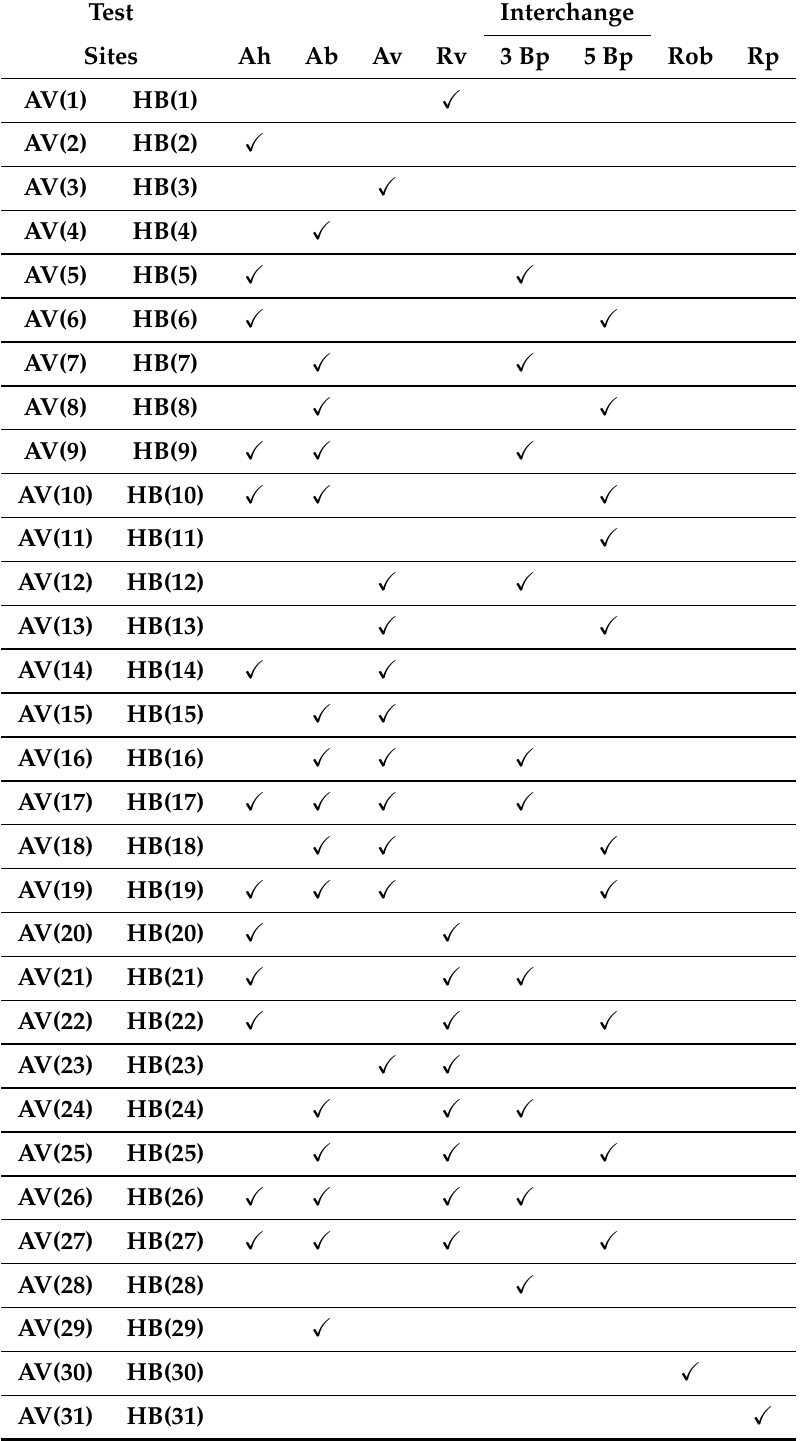
Table 1. Operations performed on reference models from Aitkenvale (AV) and Hervey Bay (HB) datasets to generate test models. Tick symbol shows a particular operation applied on a corresponding dataset. Ah, addition of height; Ab, addition of building; Av, addition of veranda; Rv, removal of veranda; Bp, building position change; Rob, rotation of building; Rp, removal of plane.